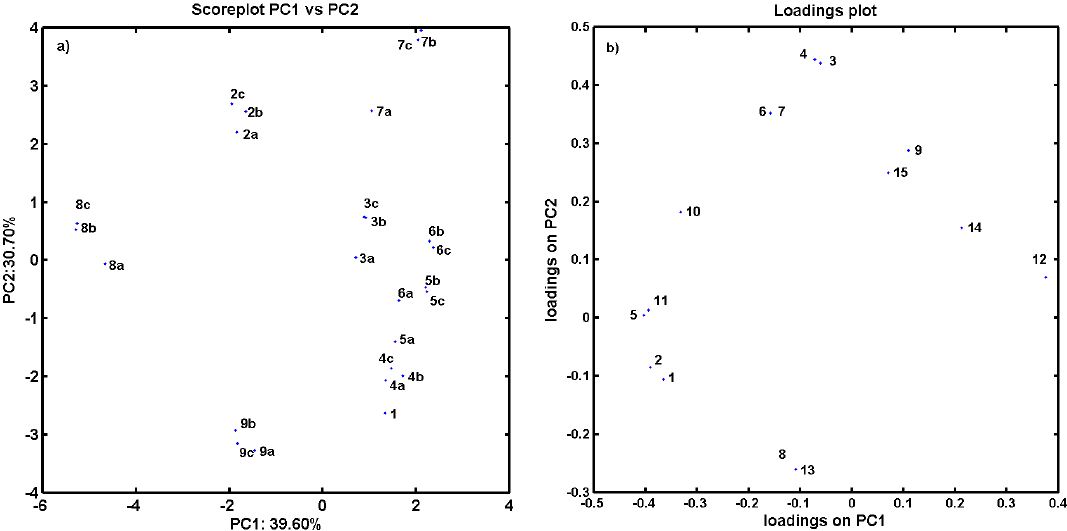
Figure 3. Projection of carbamates 1 – 9c on plane specified by first vs. second principal component ( a ); and corresponding loadings score for Sybyl descriptors ( b ).